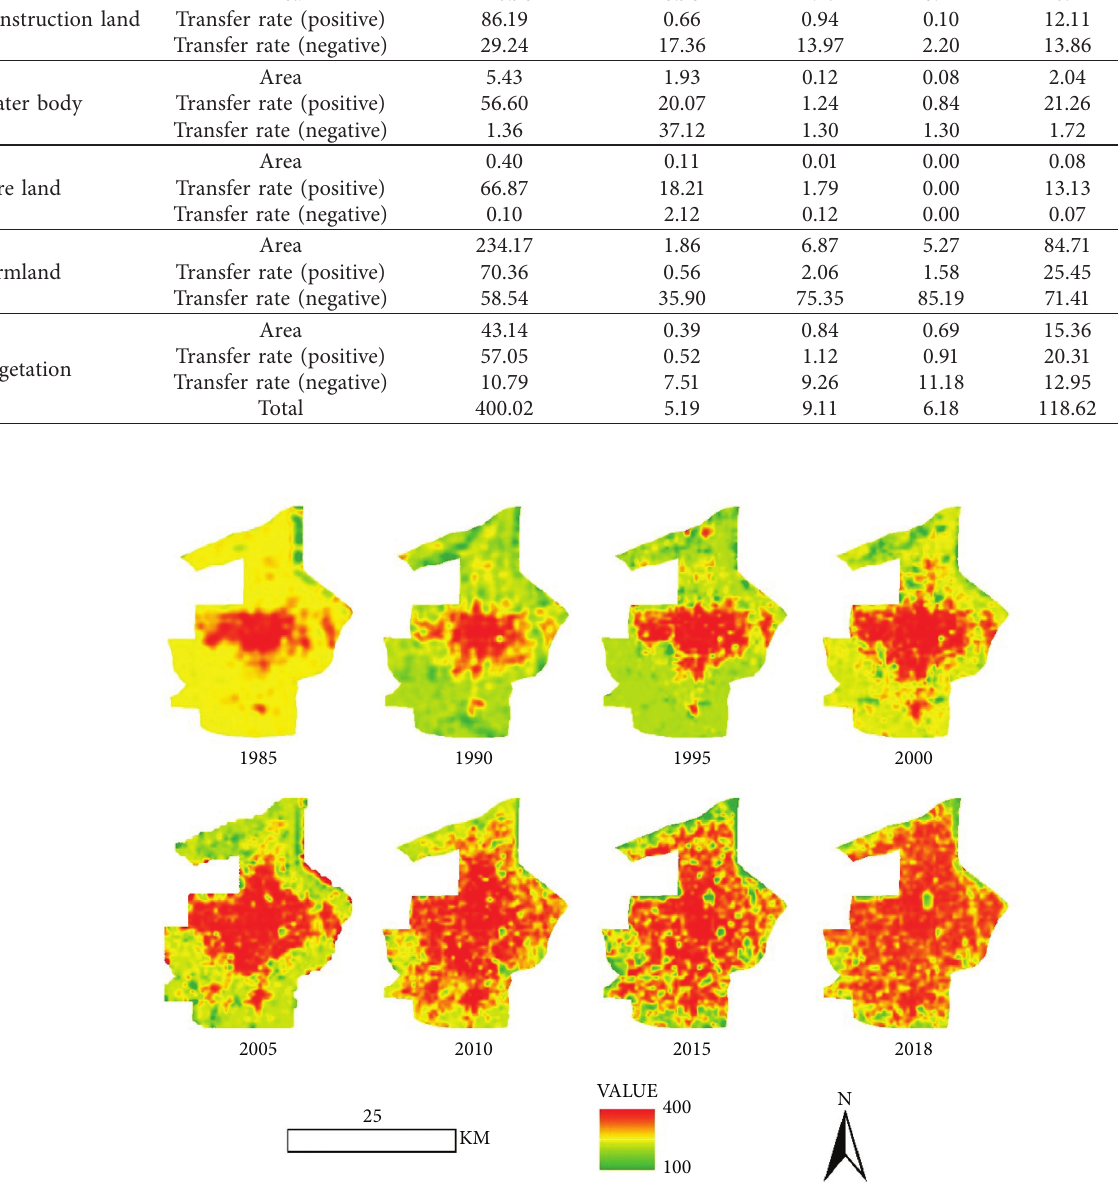
Figure 5: Spatial distribution of land use intensities in the central urban area of the study area from 1984 to